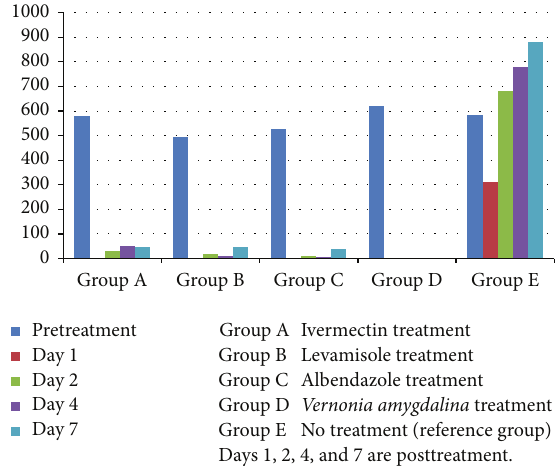
Figure 1: Graphical representation of the means for groups